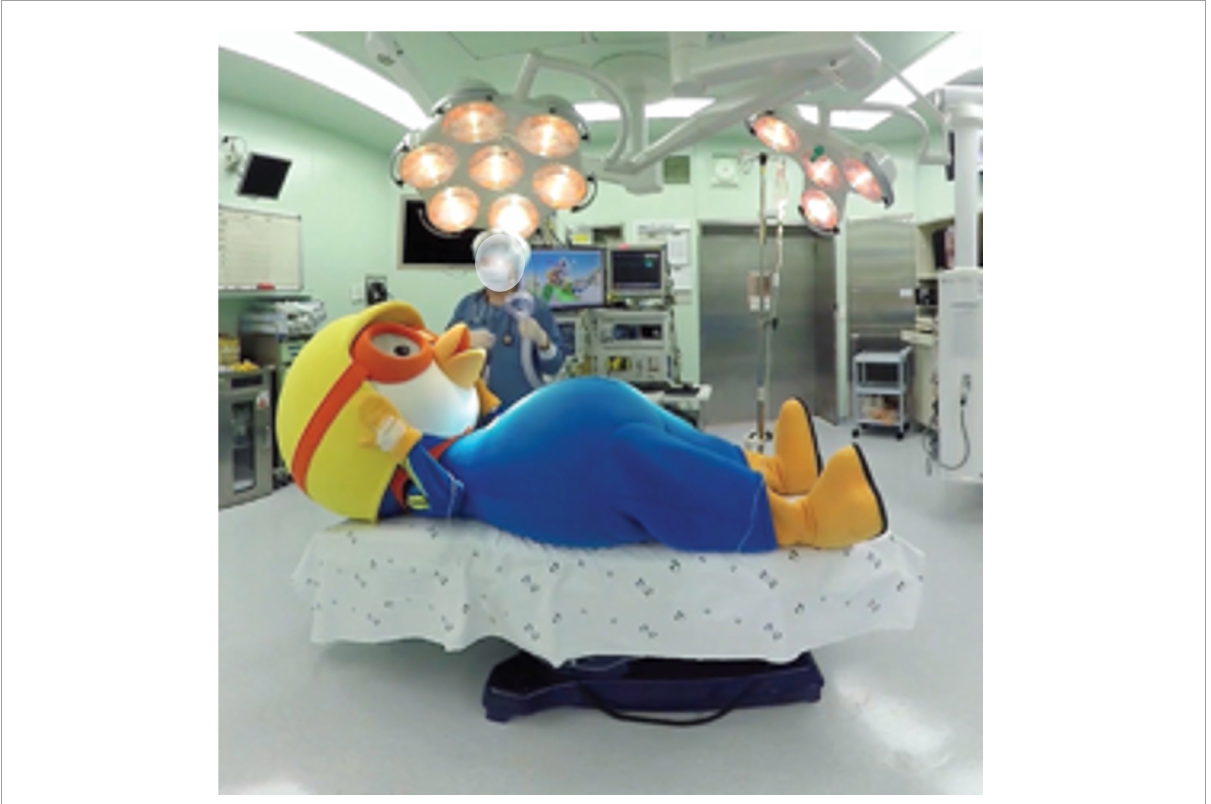
FIGURE1 Virtual reality tour. Pororo is transported to the operating room area. Monitoring devices, including ECG leads, non-invasive blood pressure cuff, and pulse oximeter, are